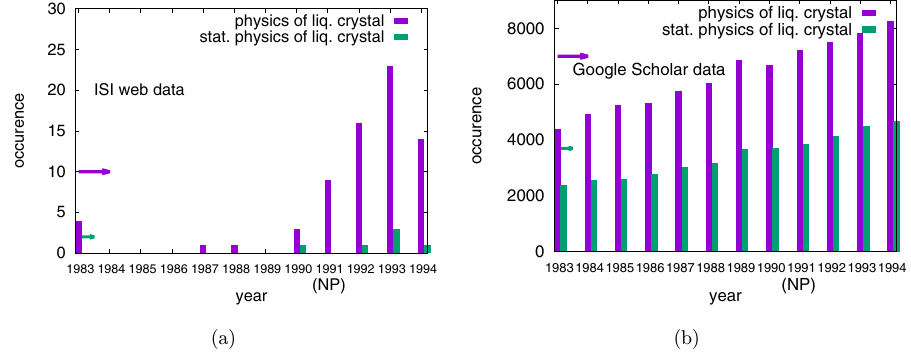
Fig. 2. (a) The number of papers on liquid crystal listed in ISI Web of Science around the year the Nobel prize was awarded in liquid crystal (1991); (b) The same is shown for the Google Scholar data.